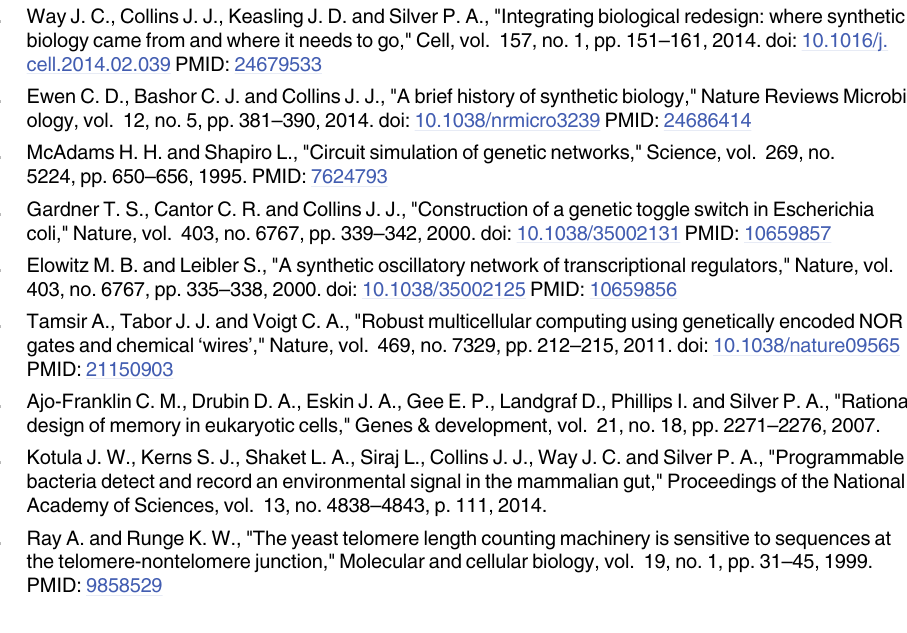
cycle. The relative strength of RBS1 and RBS2 was varied from 10, 15, 20 and 25. For each RBS1:RBS2 ratio degradation tags with half-life 2, 4, 8 and 16 minutes were used. The response is average of 20 simulation runs. S6 Fig. The robust behavior of the 1 bit pulse counter circuit against the pulse duration. Each circuit was simulation for 30 bacterial CC (30X34 minutes).The duration of the pulse (each activated at 10.2 CC (20808 sec)) was varied from 1CC (2040 sec), 2.5 CC (5100 sec), 5 CC (10200 sec) and 10 CC (20400 sec). Each figure shows the average of 20 simulation runs. (TIF) S1 File. Details of the counter